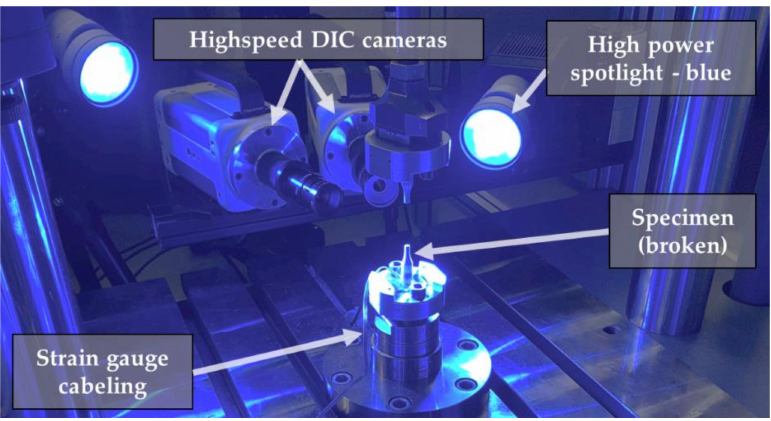
Figure 8. High-strain-rate tensile test